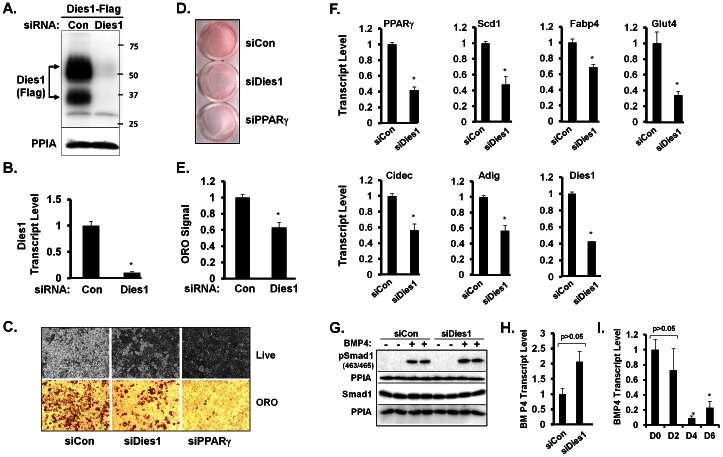
siRNA-Mediated Knockdown of Dies1 Inhibits Adipogenesis.
A. Effectiveness of siRNA for Dies1 protein knockdown. Dies1-3XFlag expression construct was transiently transfected into 293T cells along with either a control siRNA (Con) or siRNA for Dies1. Total protein was harvested 48 h later. Western blot with a Flag antibody was conducted on cell lysates with PPIA as loading control. Numbers on right indicate molecular mass markers in kDa. Two prominent species of Dies1 protein are detected (arrows), which represent products of post-translation modification by glycosylation [22]. B. Effectiveness of siRNA for knockdown of endogenous Dies1 transcript. Control (Con) siRNA or siRNA for Dies1 was introduced into 3T3-L1 adipocytes. RNA was harvested 48 h later and transcript levels for Dies1 measured by qPCR. * indicates p<0.05 compared to siCon, the value of which was set to 1. Studies in 5A and 5B were conducted in duplicate. C. Effect of Dies1 knockdown on triglyceride content during 3T3-L1 adipogenesis. 40× microscopic view of day 7 adipocytes post knockdown with siCon, siDies1 or siPPARγ. Following electroporation of indicated siRNAs into 3T3-L1 preadipocytes, cells were then subject to an adipogenic differentiation protocol. At 7 d post adipogenic induction, cells were either photographed live (upper panels) or following Oil Red O (ORO) staining of fixed cells (lower panels). D. View of complete culture wells stained with Oil Red O. Experiment was conducted as in C. Cells harboring indicated siRNA were fixed with paraformaldehyde and stained with Oil Red O. E. Quantification of adipocyte neutral lipid content. ORO was extracted from stained culture dishes and quantified by measuring absorbance at O.D. 490 nm. n = 3 wells for each of siCon and siDies1. Data shown in 5C, 5D, and 5E is representative of 3 independent experiments. * indicates p<0.05 compared to siCon, which is set to a value of 1. F. Assessment of levels of adipocyte marker transcripts. RNA was harvested from cultures of day 7 3T3-L1 adipocytes that had been subject to transfection with siCon or siDies1, as described in C. qPCR analysis was conducted for the indicated transcripts and are representative of 3 independent experiments. * indicates p<0.05 compared to siCon, which is set to a value of 1. G. Knockdown of Dies1 during 3T3-L1 adipogenesis does not abrogate BMP4-induced levels of phospho-smad1
. As described in materials and methods, 3T3-L1 cells were subject to siRNA-mediated knockdown utilizing siCon or siDies1. Two days post-knockdown, cultures were treated with BMP4 (+) or vehicle (−) for 15 minutes, and cell lysates analyzed for levels of pSmad1(Ser463/465)and total Smad1by western blot. PPIA signals are shown directly below each respective panel. H. qPCR for BMP4 transcript expression in 3T3-L1 cultures transfected with either siCon or siDies1. The samples are the same utilized in data shown in Figure 5F
. I. qPCR for BMP4 transcript expression during 3T3-L1 adipogenesis. X-axis shows days (D) post-induction of adipocyte differentiation. * indicates p<0.05 compared to the D0 and D2 samples. Studies in 5G, 5H and 5I were done in duplicate.